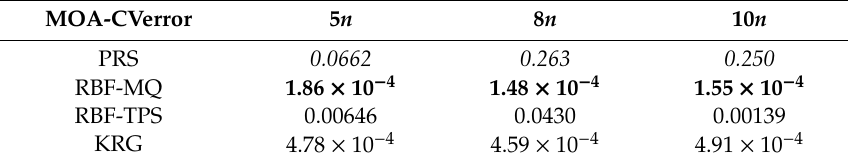
Table 12. Results of MOA-CVerror of four surrogate models.